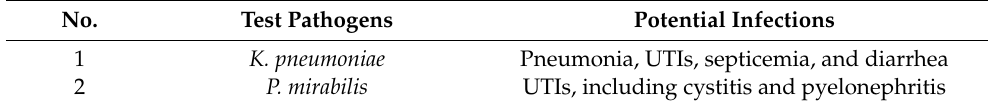
Table 7. Profile of microorganisms used in this study.